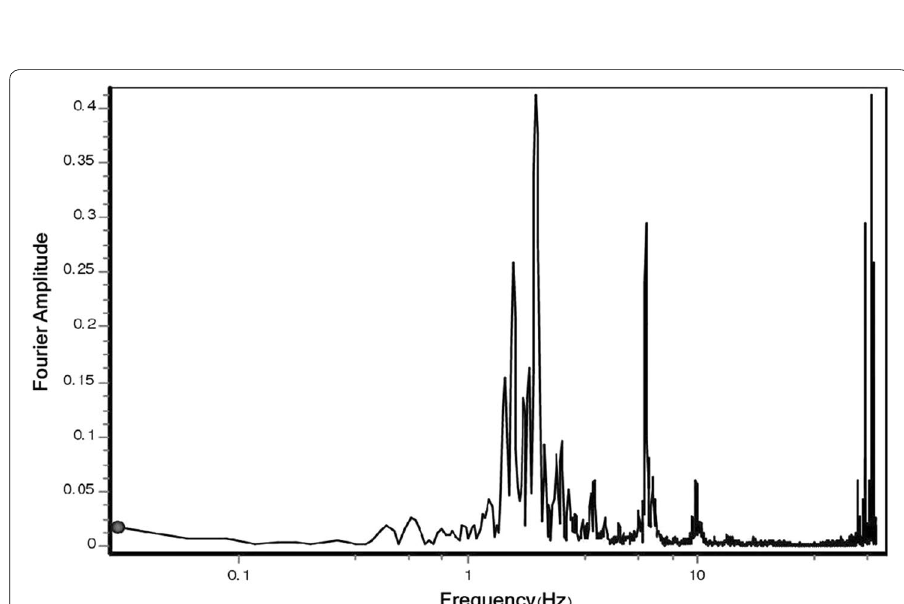
Fig. 3 Fourier spectrum of accelerometer before